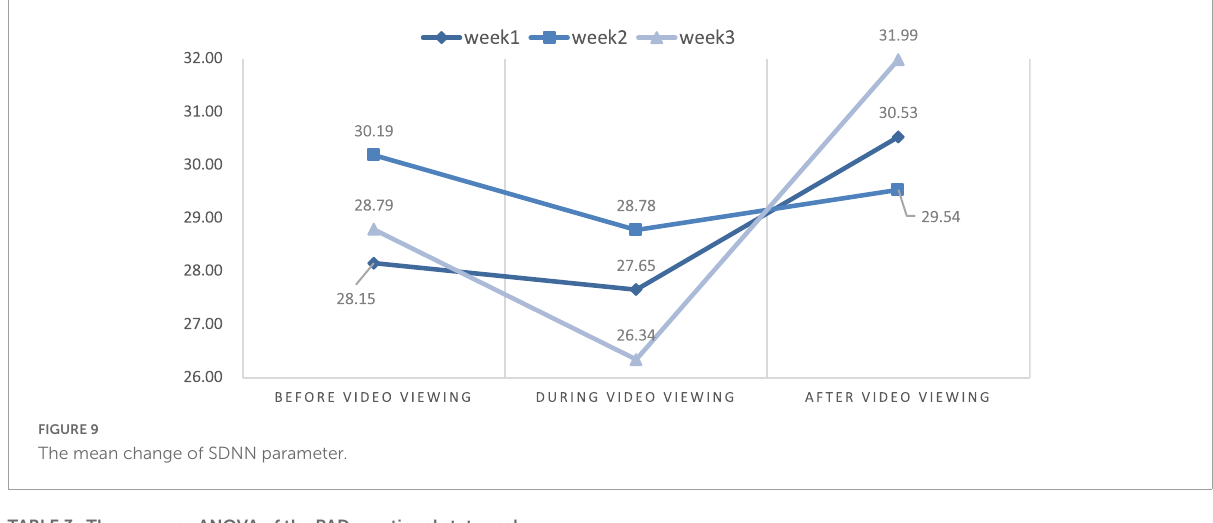
TABLE 3 The one-way ANOVA of the PAD emotional state scale.